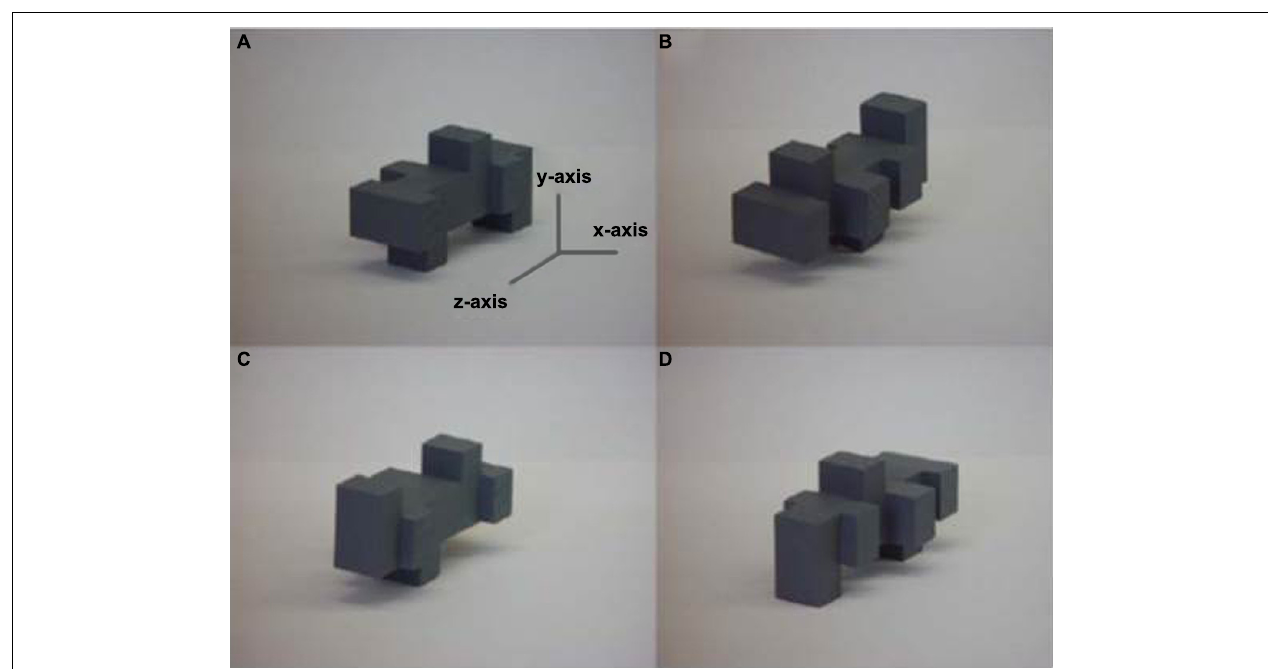
FIGURE 1 | Example 3-D unfamiliar object shown (A) in the original orientation and rotated 180 ◦ about the (B) z-axis, (C) x-axis, and (D) y-axis: rotation about the x- and y-axes are rotations in depth, rotation about the z-axis is a rotation in the picture-plane. Figure adapted from Lacey etal. (2007).